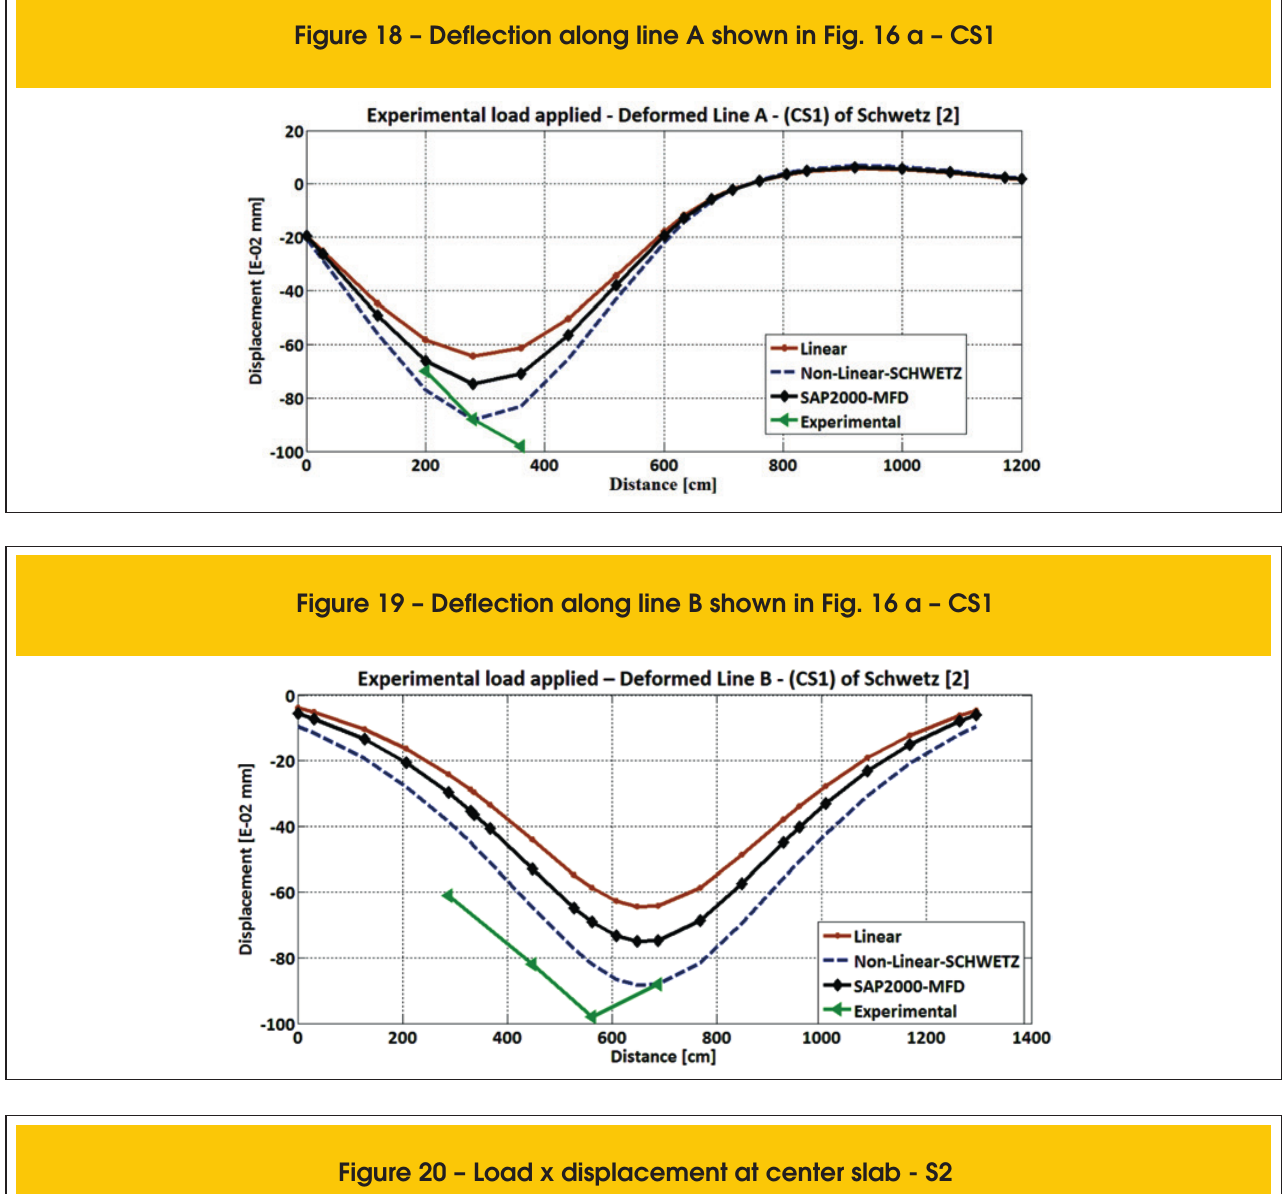
Figure 20 – Load x displacement at center slab -